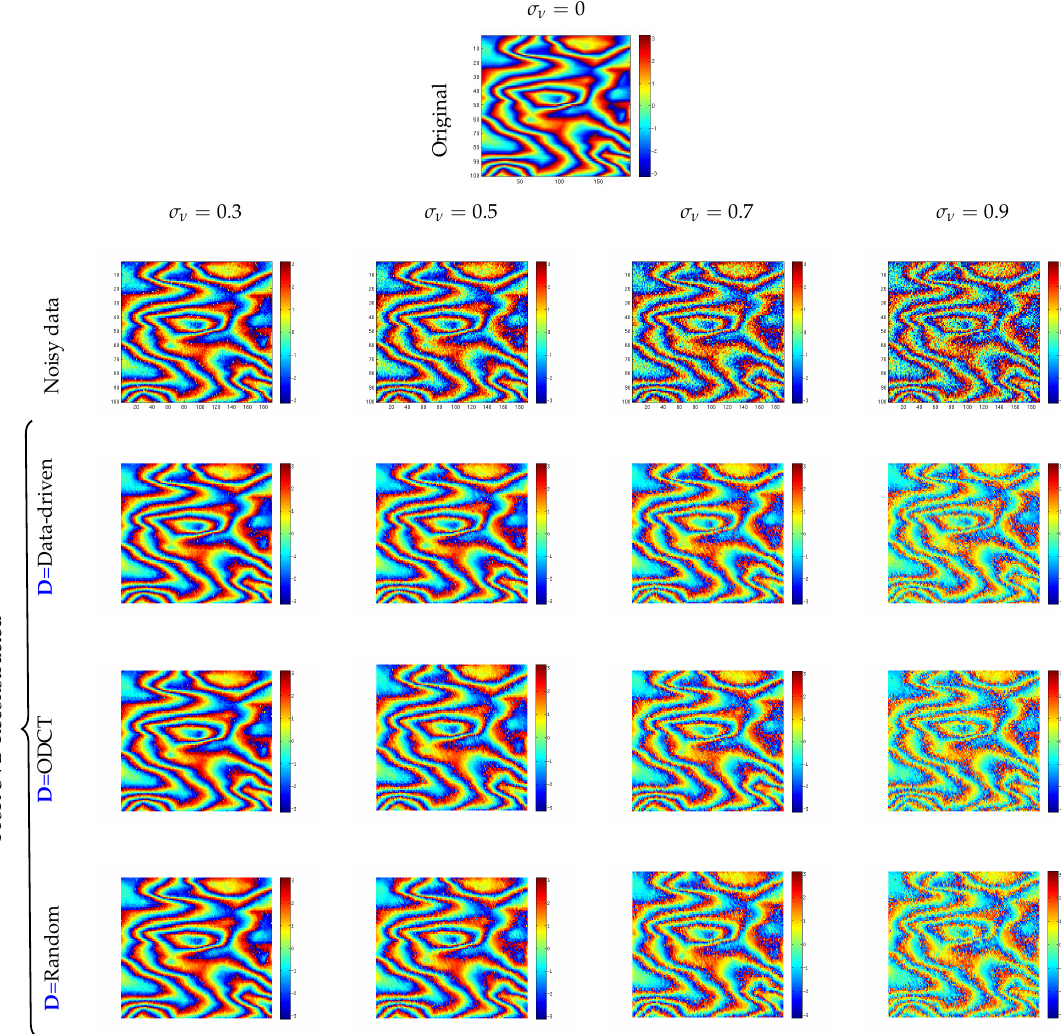
Figure 12. On top the original noisy-free map is shown. The second row displays the original phase map corrupted by additive noise with given standard deviation. The subsequent rows describe the reconstruction obtained using ProK-SVD for different initial dictionary D